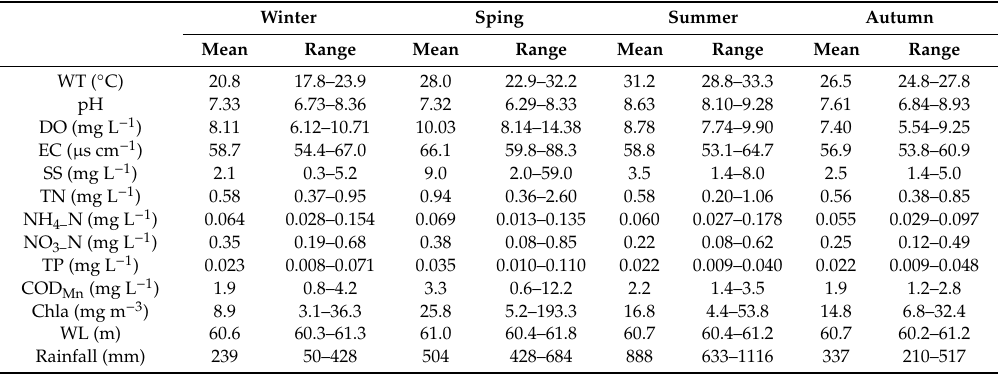
Table 3. Mean and range (Min–Max) of environmental factors in the Gaozhou Reservoir for each season from 2015 to 2017. Winter